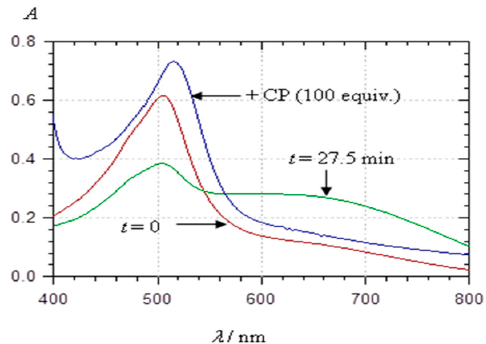
Figure 10. Visible spectra of PA1 (48.4 µ M) in a pH 4.62 acetate buffer + 12% EtOH: immediately after addition ( t = 0), after the development of self-association ( t = 27.5), and after the subsequent addition of the copigment chlorogenic acid (Copigment, 100